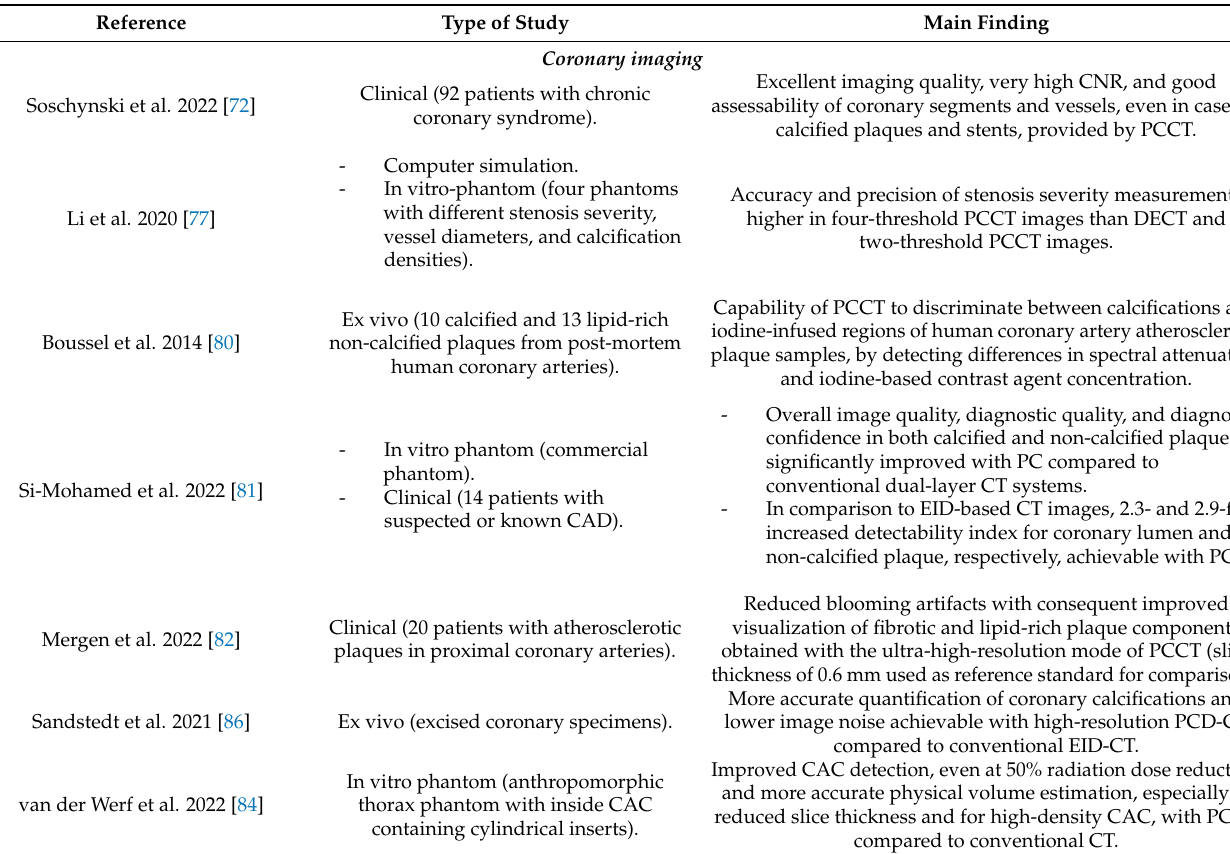
Table 1. Studies on PCCT for cardio-vascular